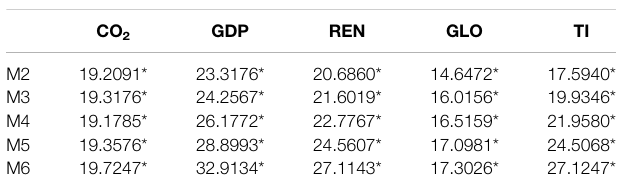
TABLE 3 | BDS test. TABLE 4 | ZA